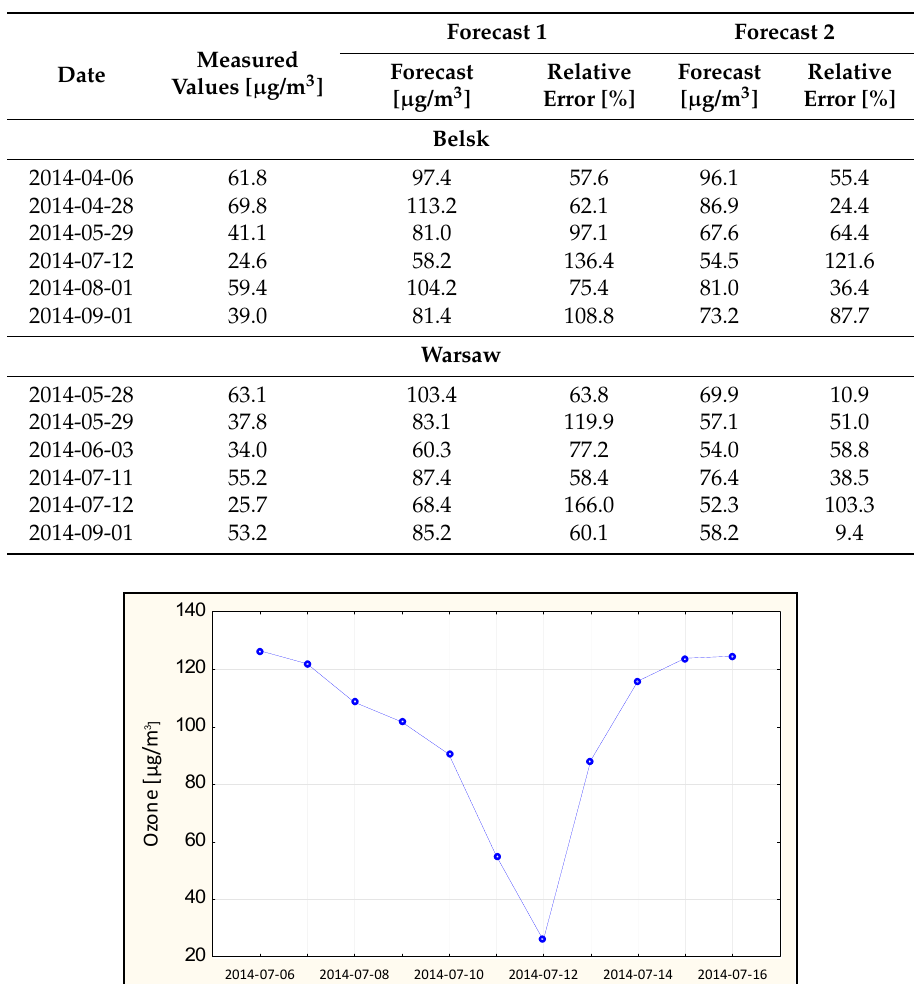
Table 10. Comparison of the results of two predictions using forecasted meteorological parameters as input variables (Forecast 1) and using real meteorological parameters as input variables (Forecast 2) performed for the days with relative error value >50%.